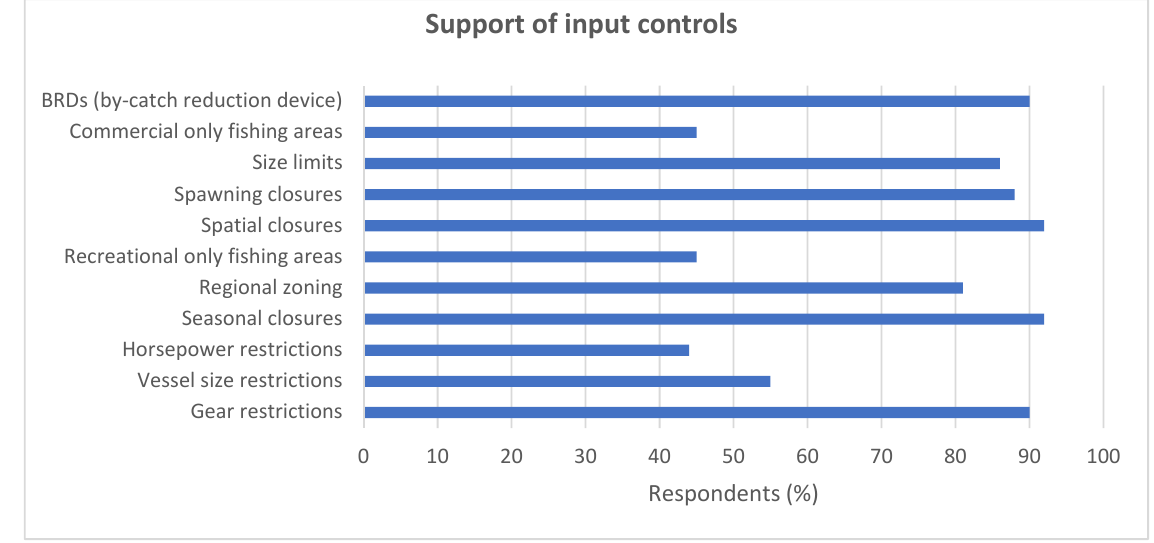
Figure 14. The level of support for several input controls shown by marine experts (n = 162).